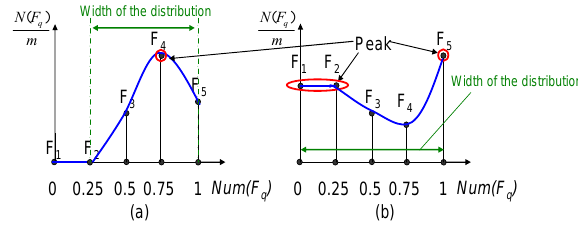
Fig. 3. Two fuzzy sets describing the relationship between t k and s